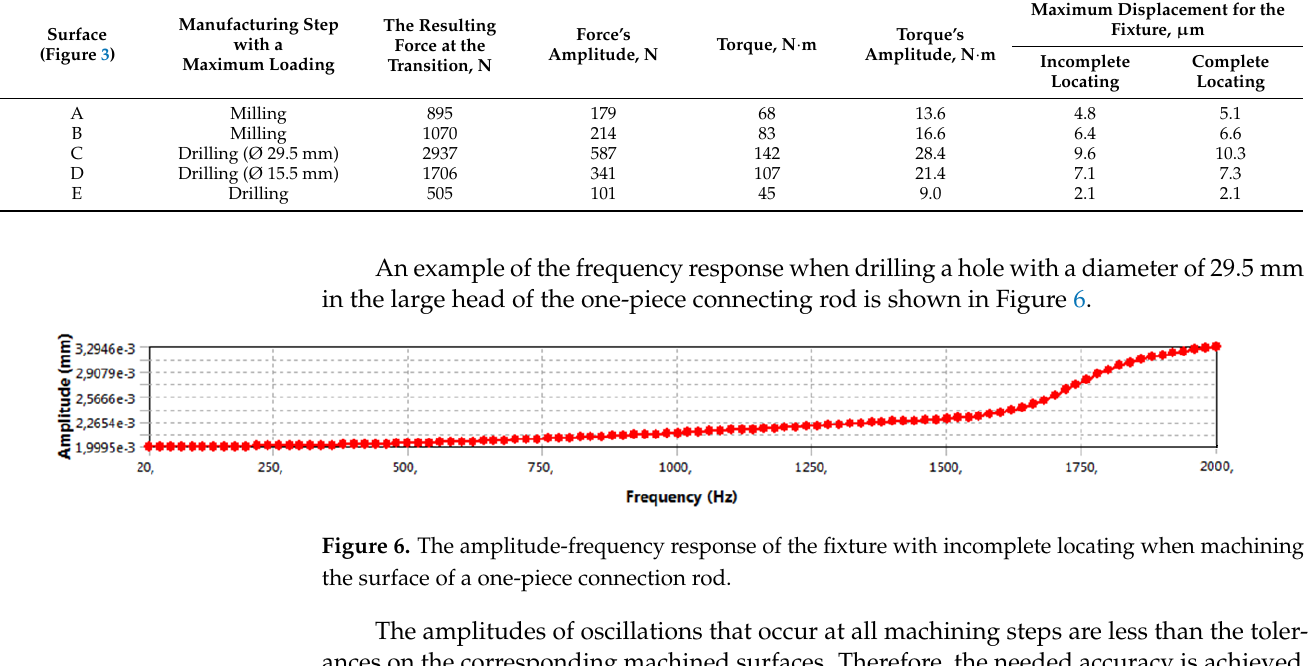
Table 5. The results of the dynamic analysis.